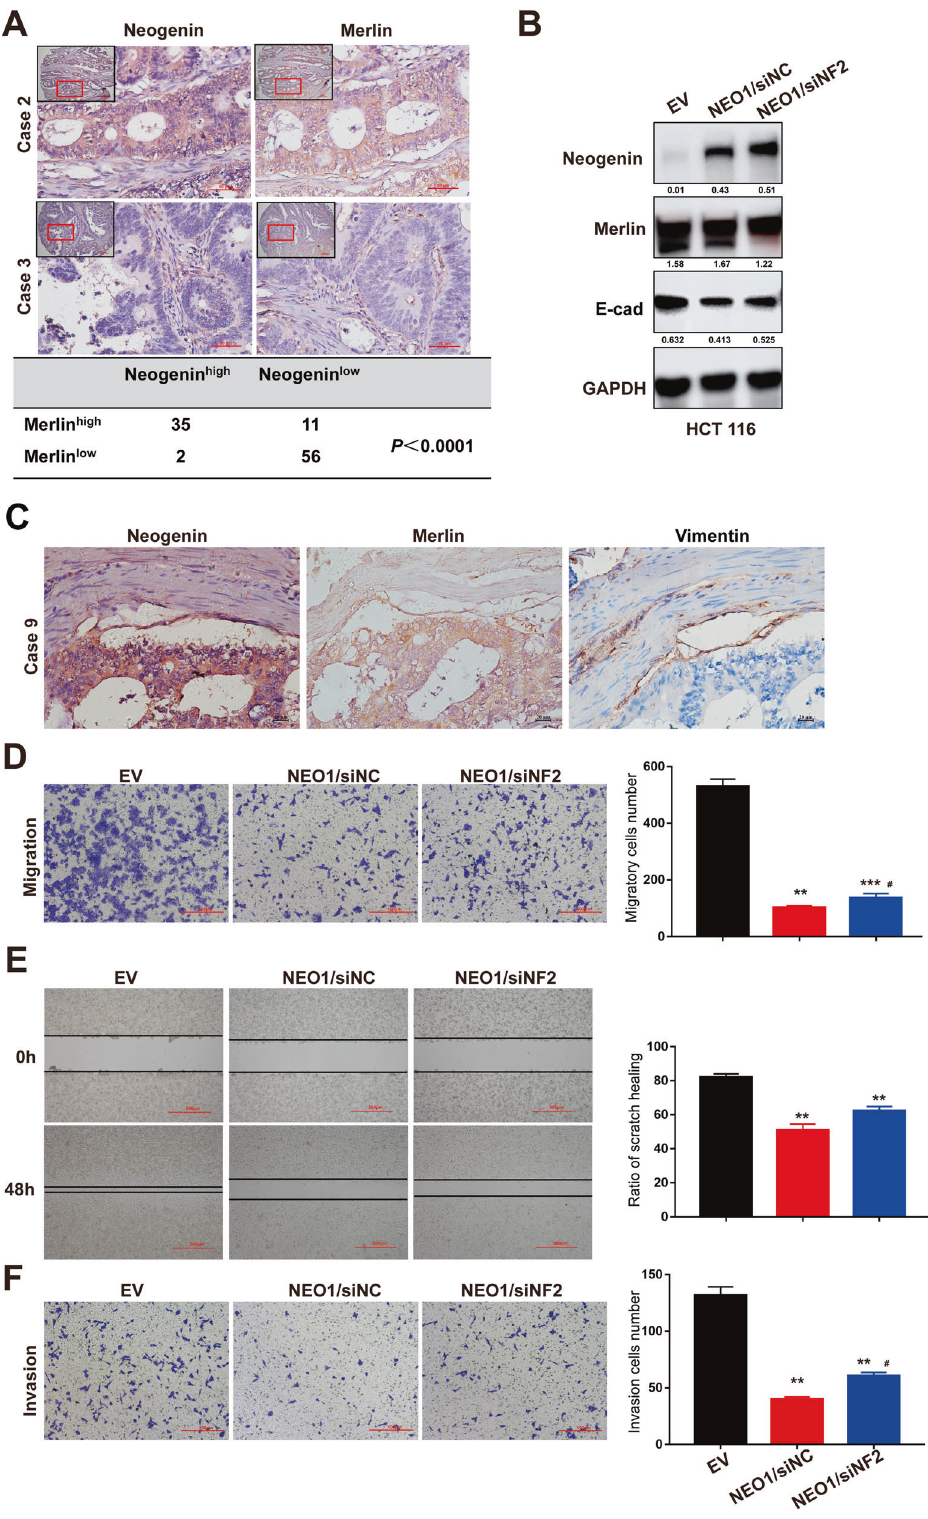
Signi fi cantly, CRC patients with low Neogenin expression types of tumors negatively correlates with Neogenin